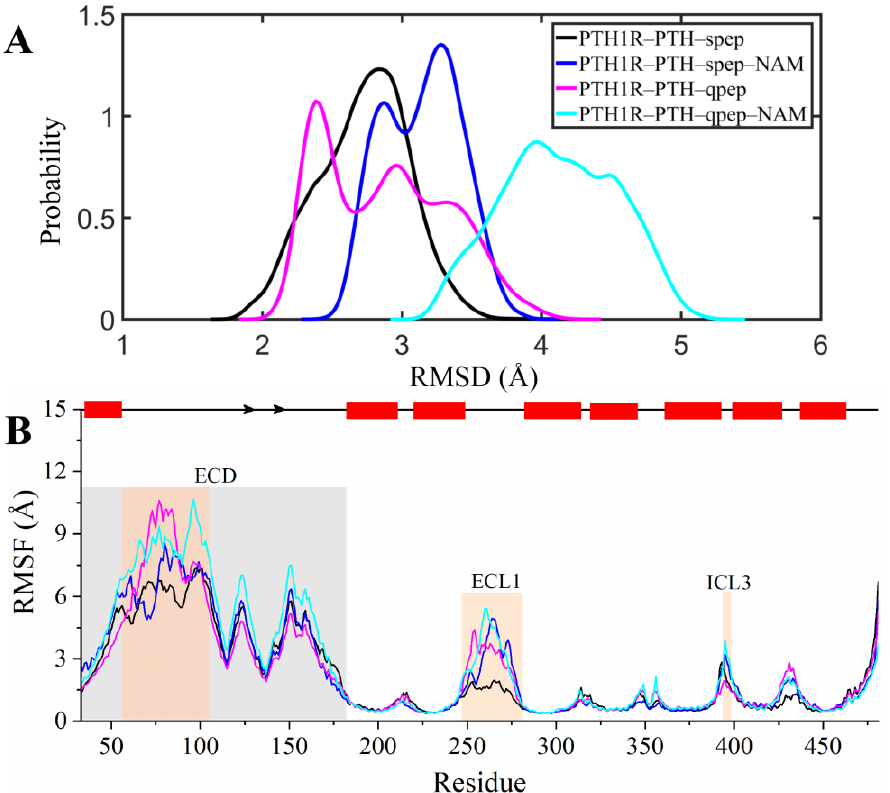
Figure 2. The C α RMSD probability distribution profiles ( A ) and RMSF ( B ) values during the last 300 ns. The rectangles and arrows on the top represent ordered secondary structures for α -helices and β -sheets, respectively. The ECD is highlighted by shading in gray, and modeled regions in ECD, ECL1, and ICL3 are highlighted in orange.